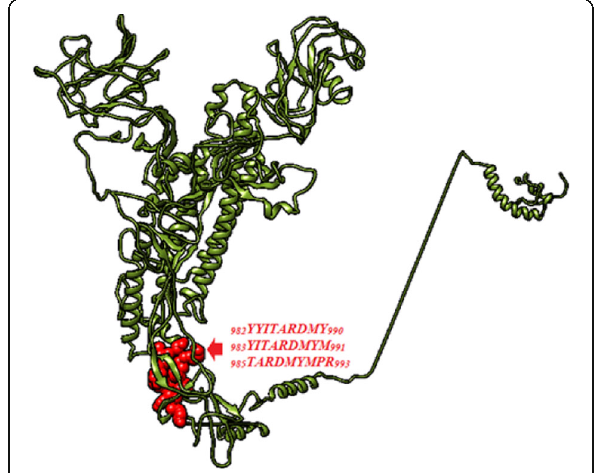
Fig. 6 The position of proposed MHCI and MHCII epitopes (sphere red colour) in the 3D structure of spike protein of IBV illustrated by UCSF-Chimera visualization